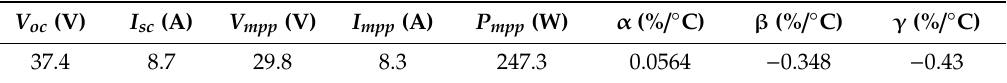
Table 2. Datasheet information of Tenesol TE245-60M.